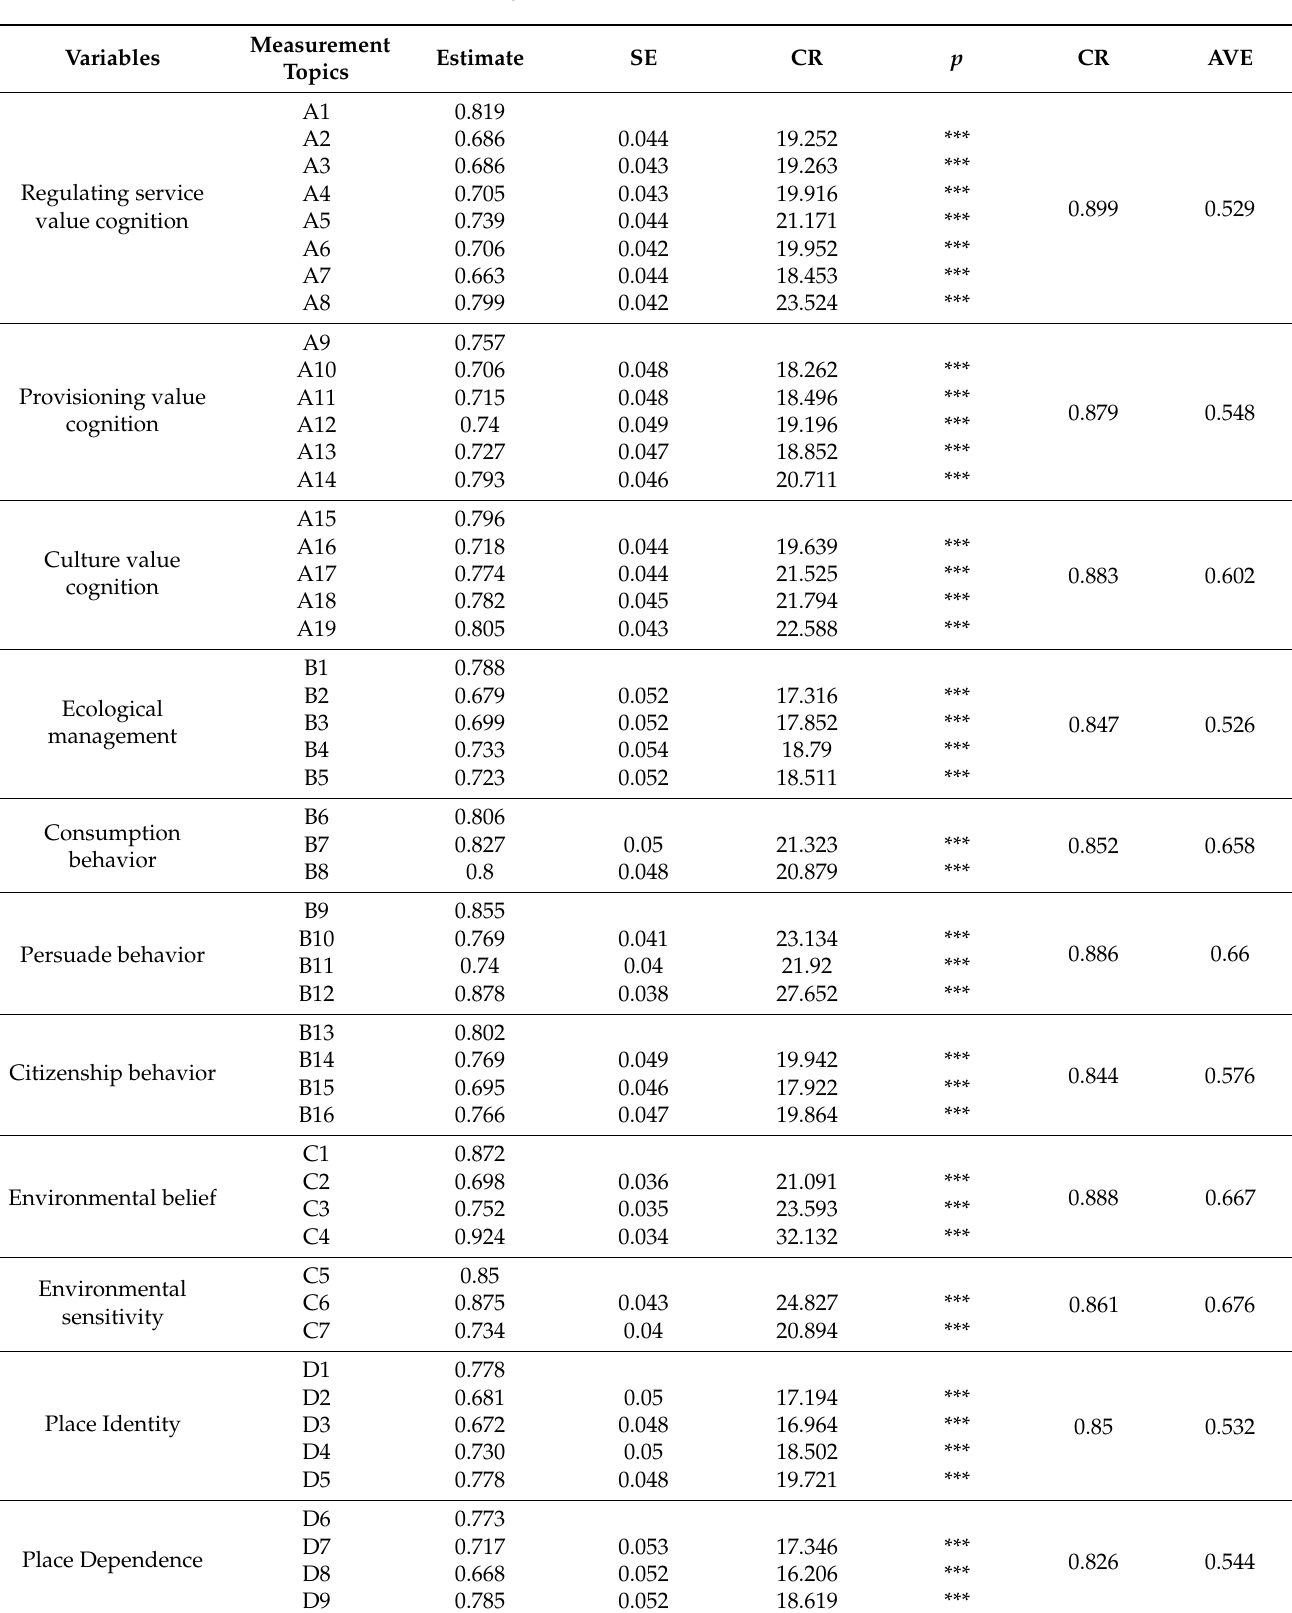
Table 8. Factor analysis